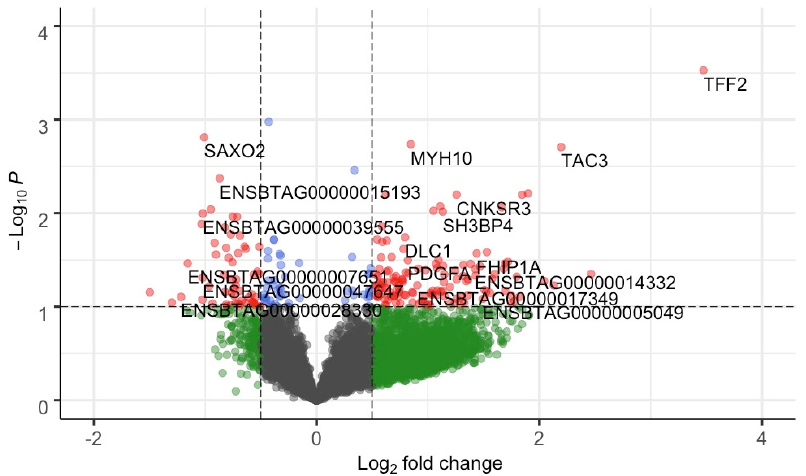
Figure 1. Schematic representation of the study design and analysis steps. The yellow boxes repre- sent the analysis steps; the green boxes represent the software/packages used; and the blue boxes represent the output obtained. The red connectors point to the main analysis steps, while the green connectors are the analysis after filtering. * Differentially expressed metabolites retrieved from Phil- lips et al. [25].